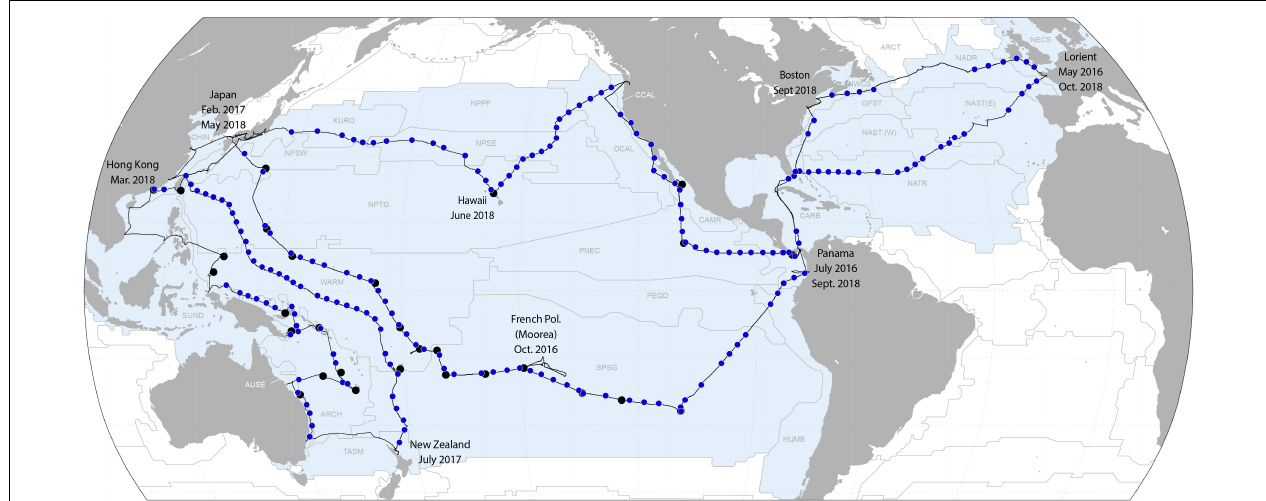
FIGURE 10 | Geographic locations of night-time HSN tows overlaying the oceanic biogeographical provinces as defined by Longhurst